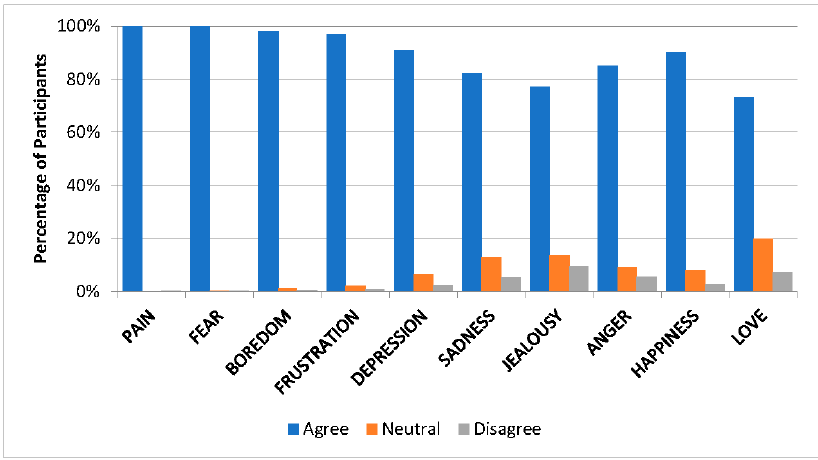
Figure 2. Viewpoints of participants (n = 901) measured using a Likert-scale (agree, neutral, disagree) regarding the ability of horses to feel various affective states. Responses of “strongly agree” and “agree” were combined, as were “strongly disagree” and “disagree”.